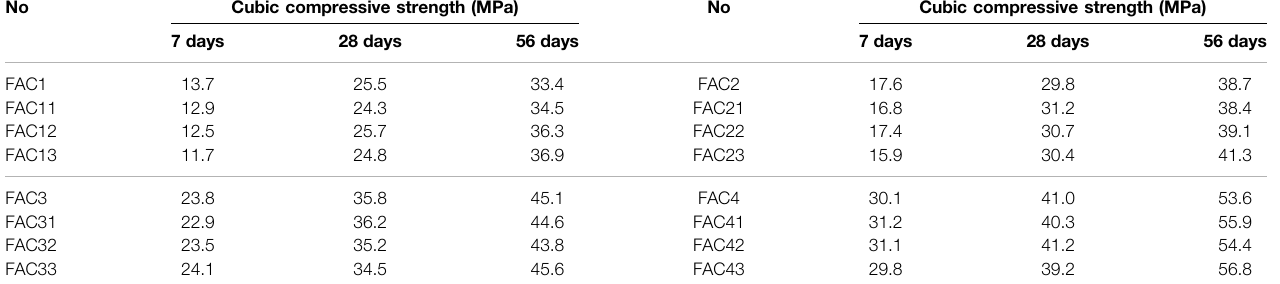
TABLE 5 | Cubic compressive strength of FAC at different curing ages.